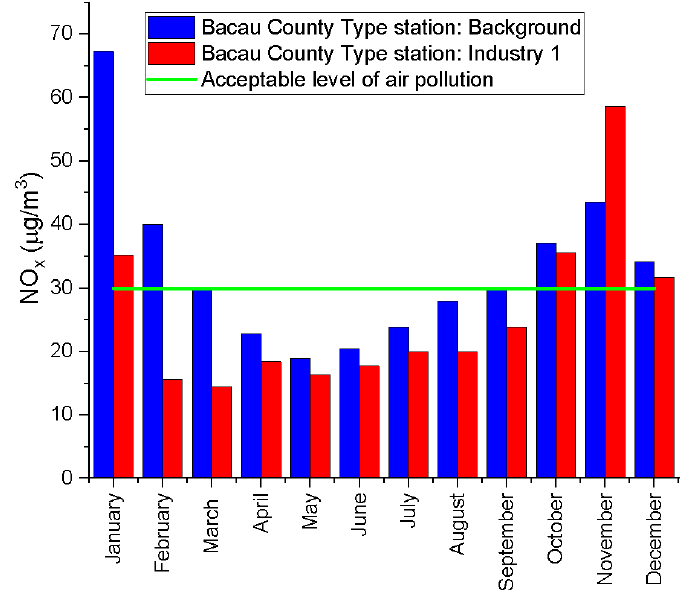
Figure 23. Average NO X concentration in individual months of 2020.